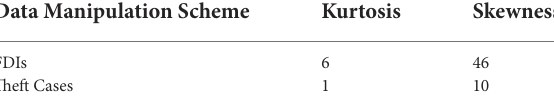
TABLE 2 Data distribution analysis. Data Manipulation